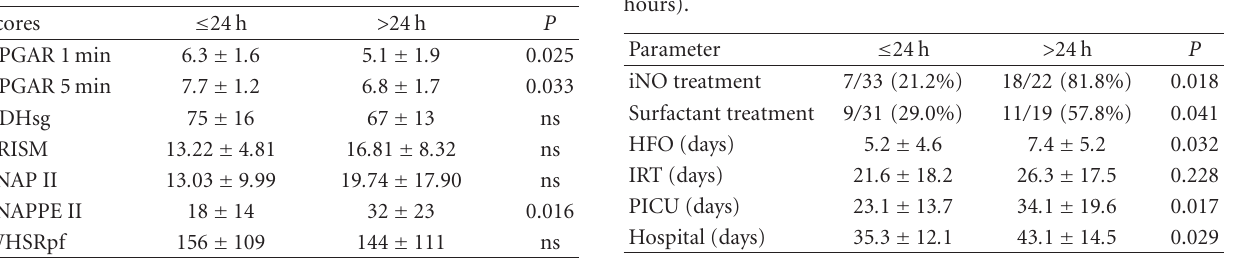
Table 3: Comparison of severity scores in the 55 patients stabilized and submitted to surgery, divided into two groups according to the duration of preoperative stabilization stage ( ≤ 24 hours or > 24 hours).